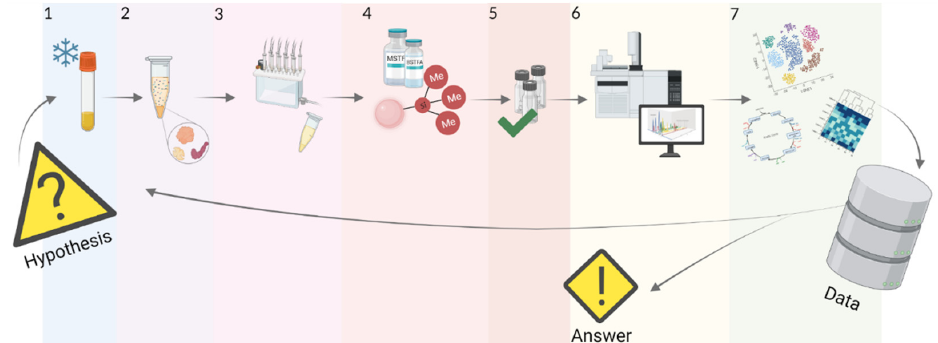
Figure 3. Stages of standard GC-MS analysis of plasma or serum samples. In a hypothesis-driven study, a metabolomic experiment starts with formulating a hypothesis, which further work will be aimed at confirming or refuting. Preanalytic operations involve quenching enzymatic processes (stage 1) in every biological sample from a representative sample. Further, the sample is purified (stage 2) from interfering protein molecules, followed by liquid or solid-phase extraction (stage 3), which allows the release of metabolites from the plasma or serum matrix and concentrates them in a smaller volume. Next, extracted metabolites are derivatized (stage 4) to improve their volatility and thermal stability. After ensuring that the quality criteria (stage 5) are met, the researcher performs a gas chromatography-mass spectrometric experiment (stage 6). Finally, data processing (stage 7) provides the researcher with either an answer to the original question or the basis for starting a new data-driven study